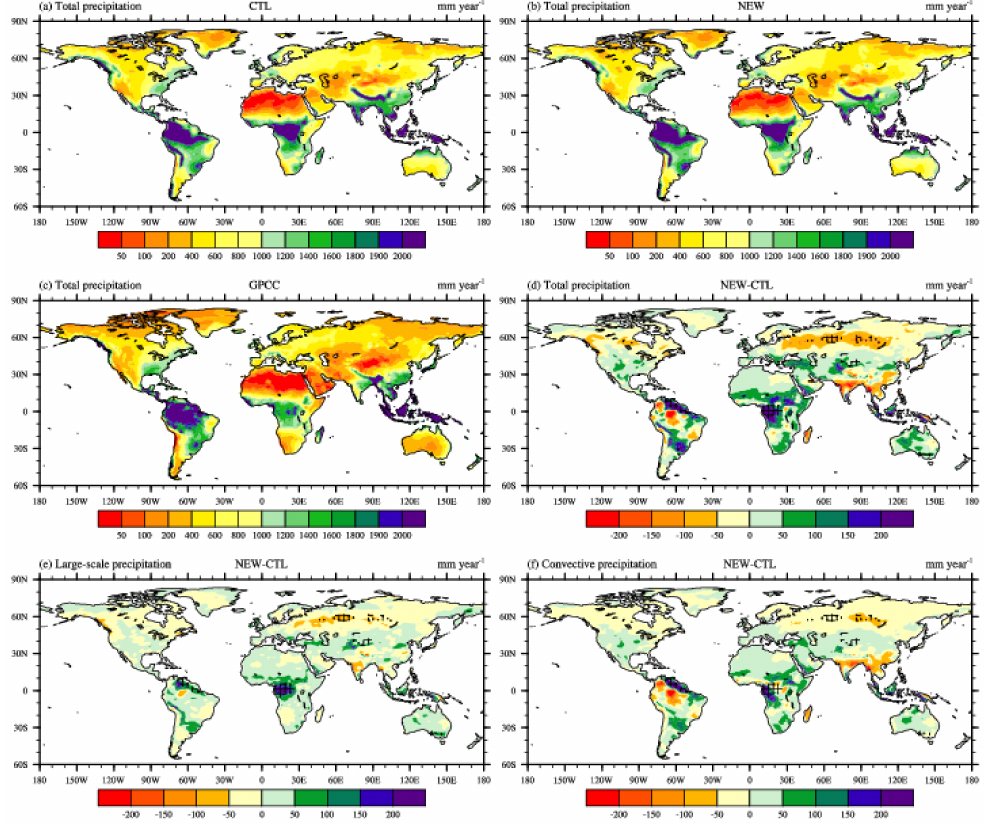
Figure 7. Twenty-four-year (1982–2005) mean precipitation (PR, mm year − 1 ) for ( a ) total precipitation of the CTL run; ( b ) total precipitation of the NEW run; ( c ) total precipitation from GPCC ( d ) difference in total precipitation between NEW and CTL; ( e ) difference in large-scale precipitation between NEW and CTL; ( f ) difference in convective precipitation between NEW and CTL. (Grid shaded regions are significant at the 95% confidence level according to Student’s t